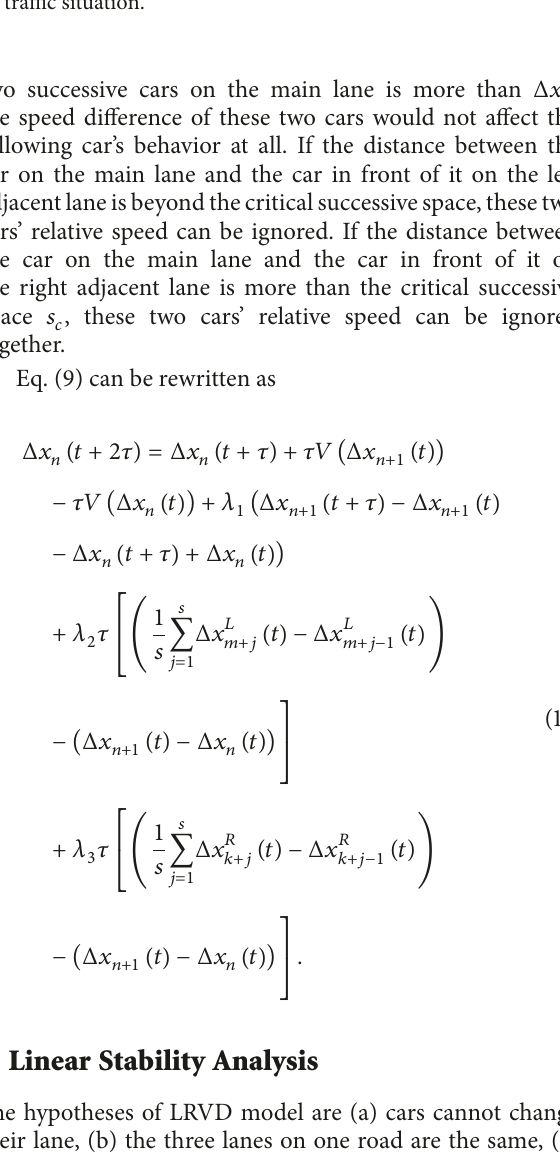
Figure 1: Three-lane road traffic